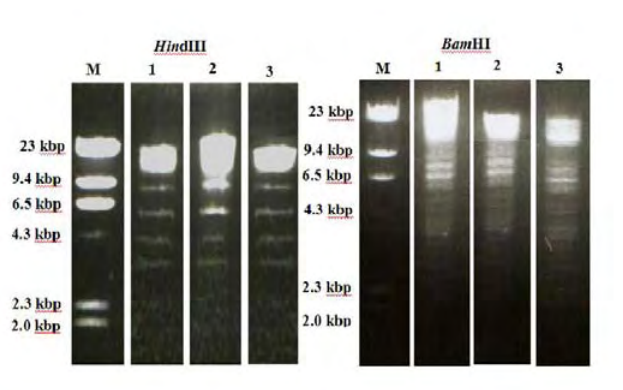
Figure 4: Restriction endonuclease profiles of